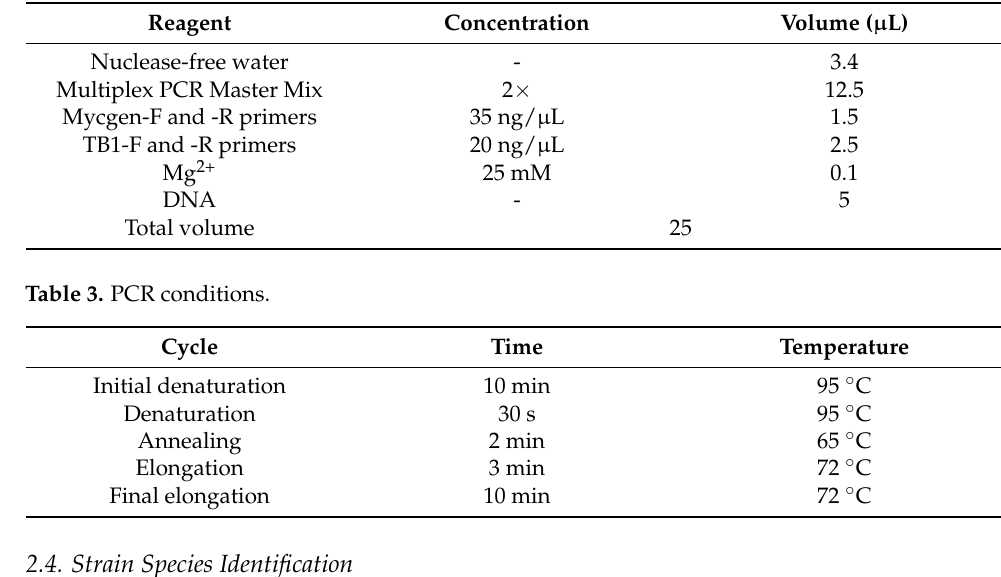
Table 3. PCR conditions.